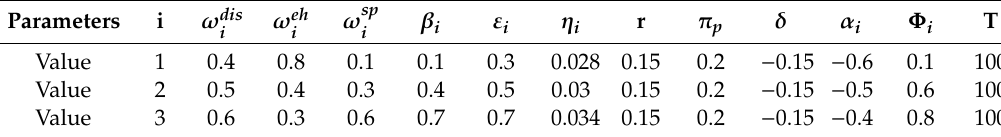
Table 1. Simulation parameters setting in the di ff erential game